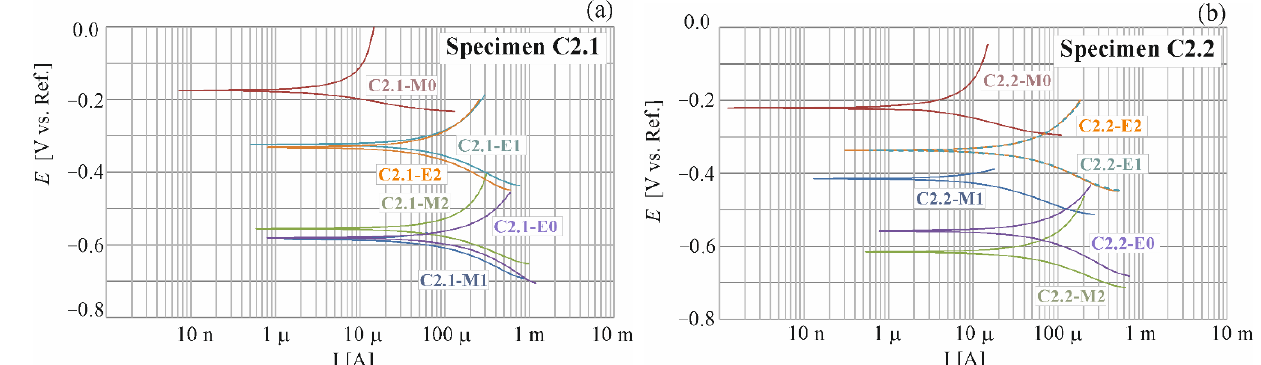
after 21 days of chloride extraction.